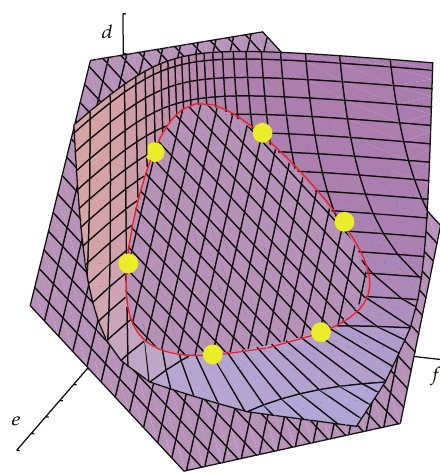
Figure 5: Three particle phase